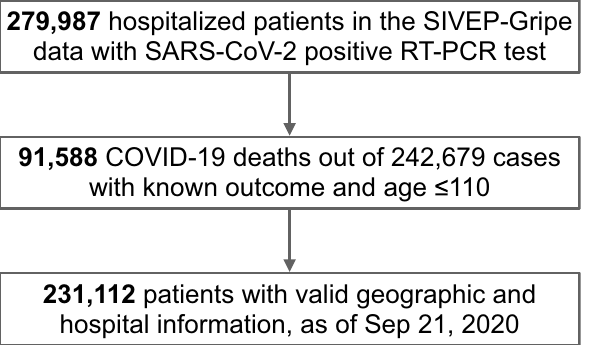
Figure 2. Flowchart of SIVEP-Gripe data used in this study. SARS-CoV-2 stands for severe acute respiratory syndrome coronavirus 2. SIVEP-Gripe stands for Sistema de Informação de Vigilância Epidemiológica da Gripe .